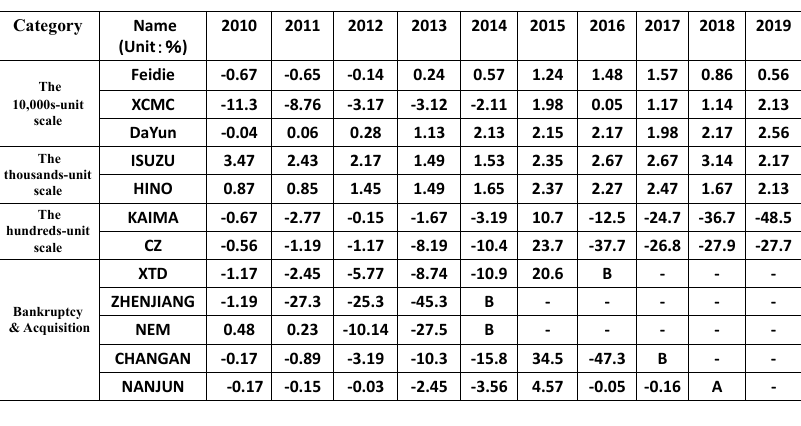
Source: China Automotive Technology and Research Center